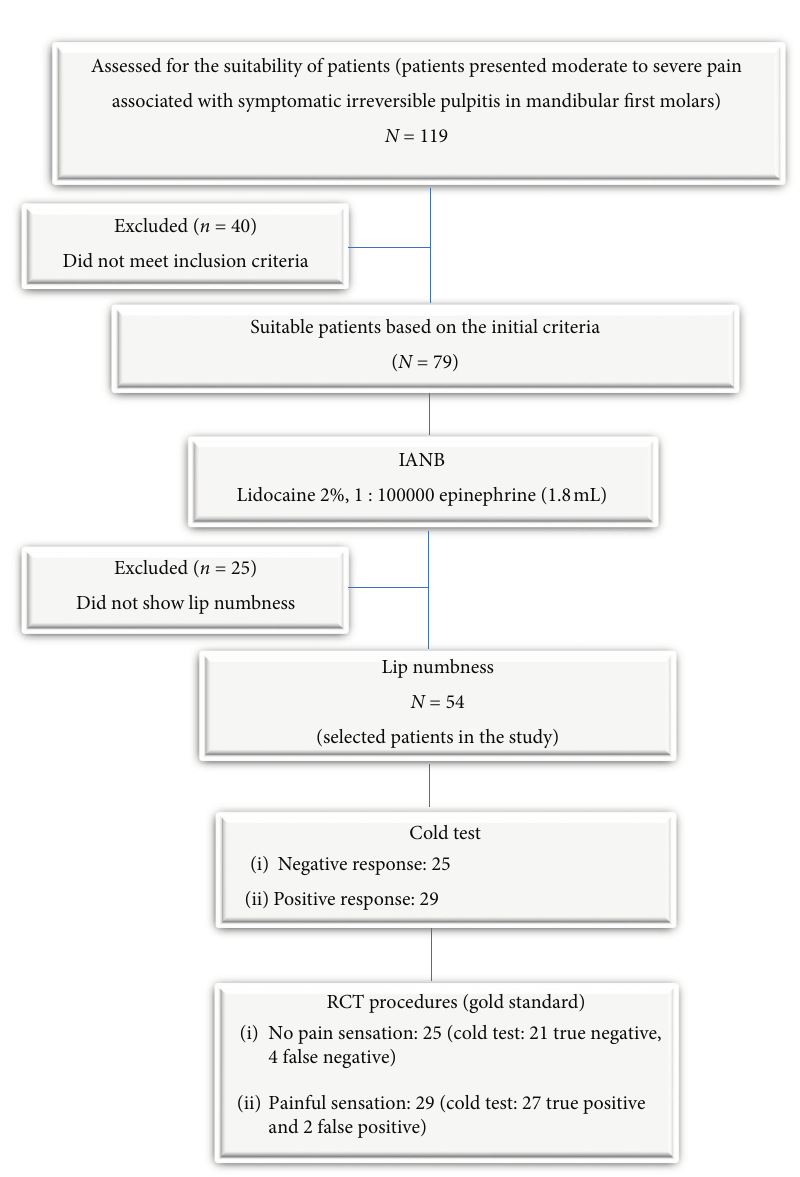
Figure 1: A flowchart of the clinical study.